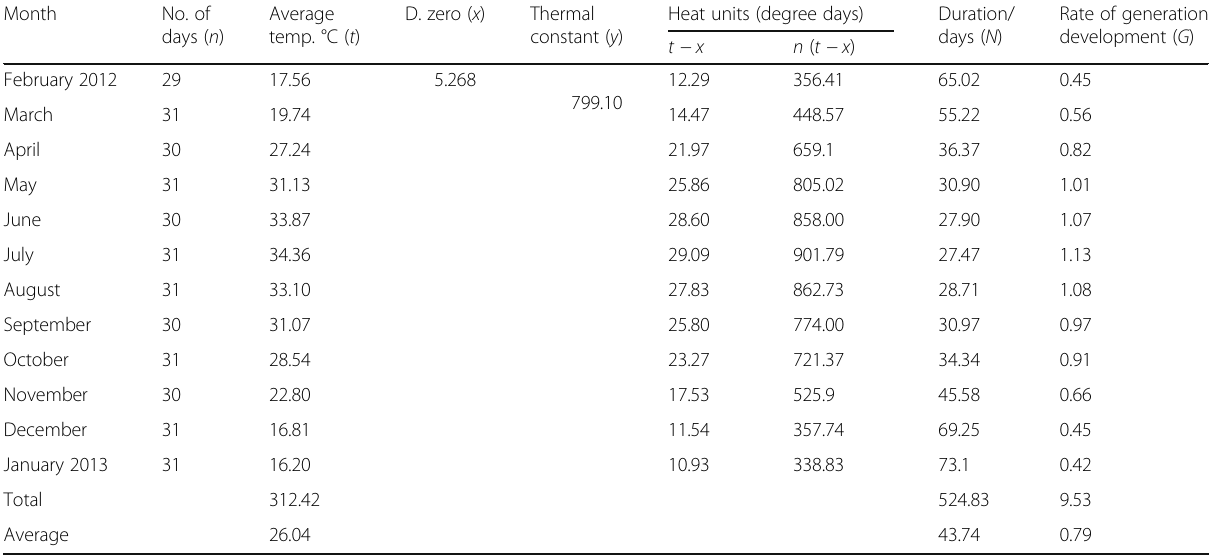
Table 4 Calculated heat units required for life cycle of females of Tuta absoluta in Qena governorate during 2012